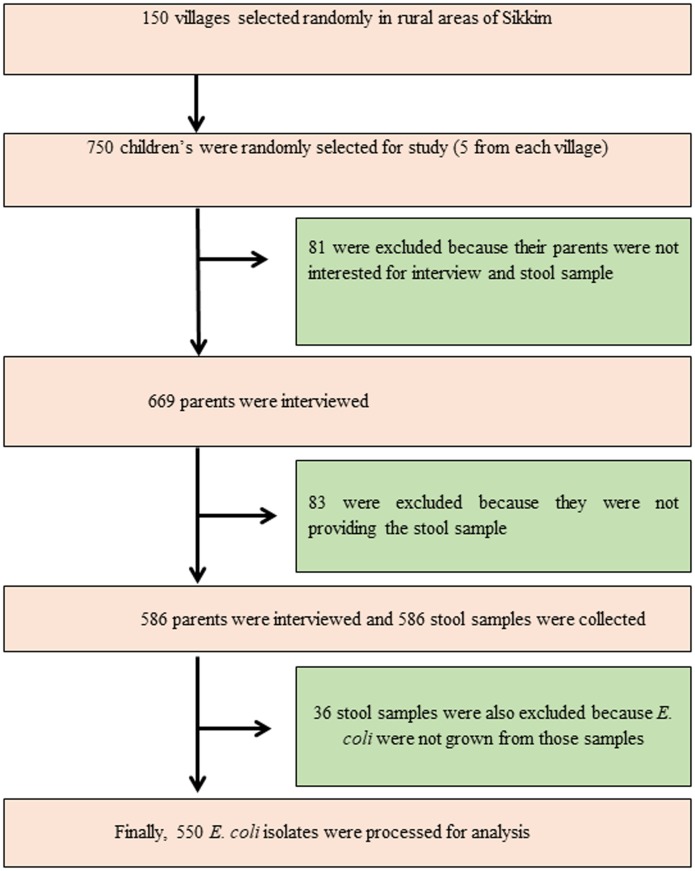
Study design.Informed written consent from parents/guardians were procured on the proforma (S1 File). Total 586 stool samples were collected from children of age group 1–14 years. Of the 586 stool samples, 36 stool samples were excluded as no definitive E. coli isolates could be cultured from those samples. A total of 550 E. coli isolates from 550 samples were used for the analysis.